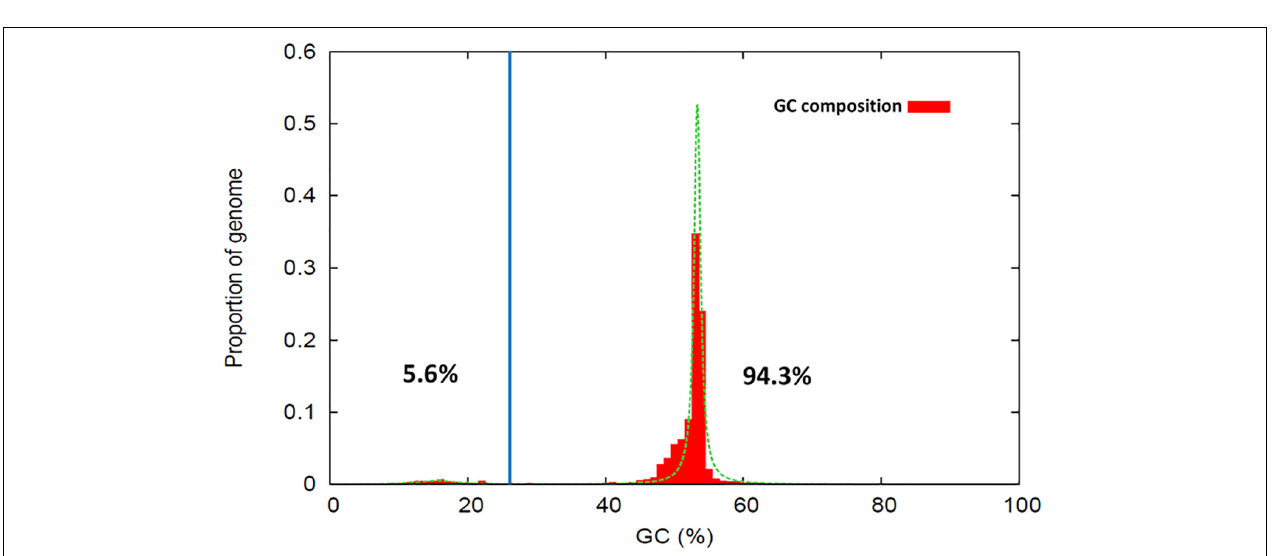
FIGURE 2 | RIPCAL analysis of the TART_DV repeat family showing dominant CpT«-»TpT + ApG«-»ApA type RIP mutation. (Top) Multiple alignment of the putative transposon repeat family TART_DV compared to the model sequence with the highest G:C content. Black = match; gray = mismatch; white = gap. Mismatches corresponding to selected di-nucleotide changes are colored as indicated. (Below) RIP mutation frequency graph corresponding to the alignment above, demonstrating the prevalence of CpT«-»TpT + ApG«-»ApA mutations.